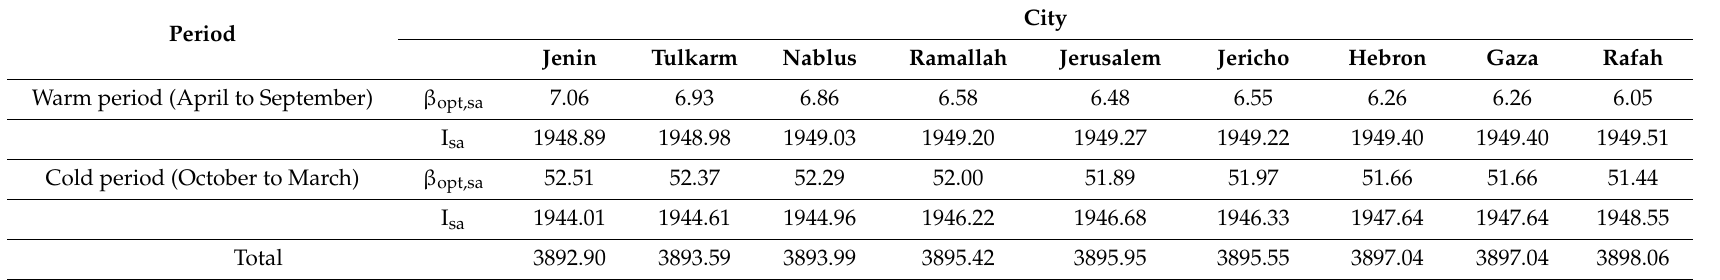
Table 11. The semi-annual optimum tilts angle β opt,sa and extraterrestrial radiation I sa in kWh / m 2 for the main Palestinian cities. Period